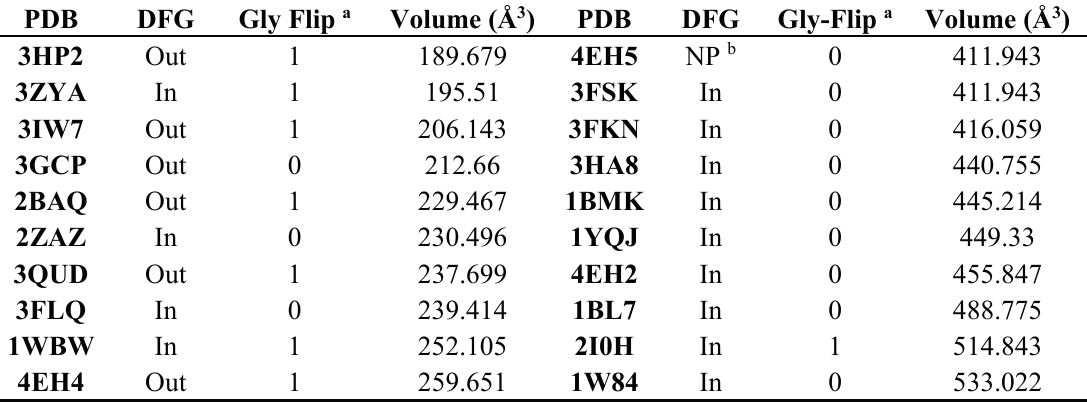
Table 1. SiteMap ATP-binding site volumes in relation to the DFG and hinge